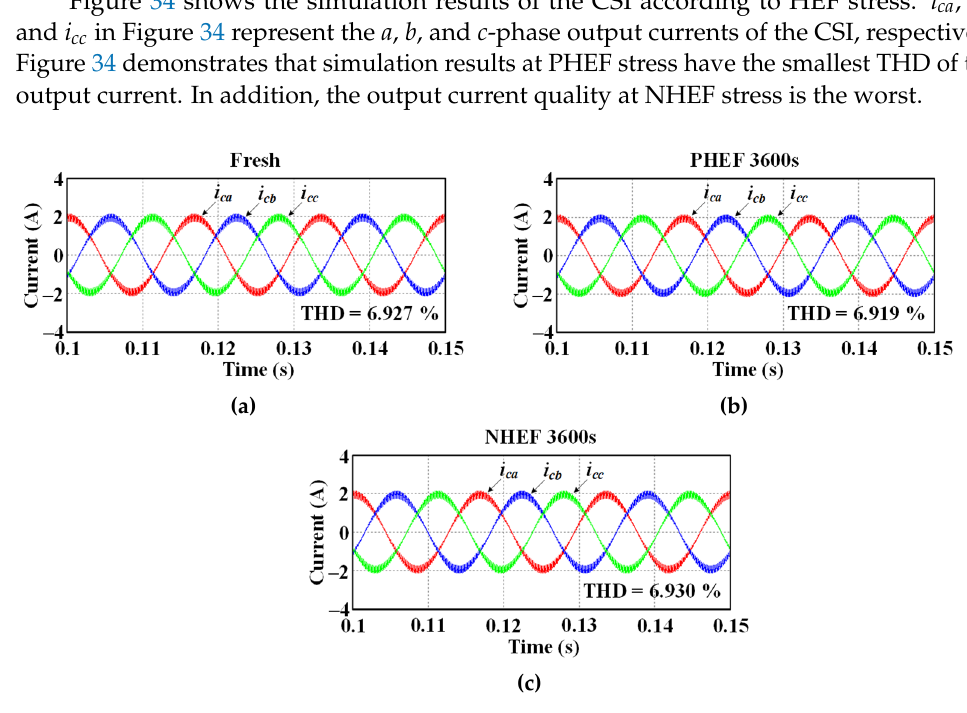
Figure 34. Simulation results of the CSI according to HEF stress: ( a ) fresh condition, ( b ) PHEF stress during 3600 s, and ( c ) NHEF stress during 3600 s.